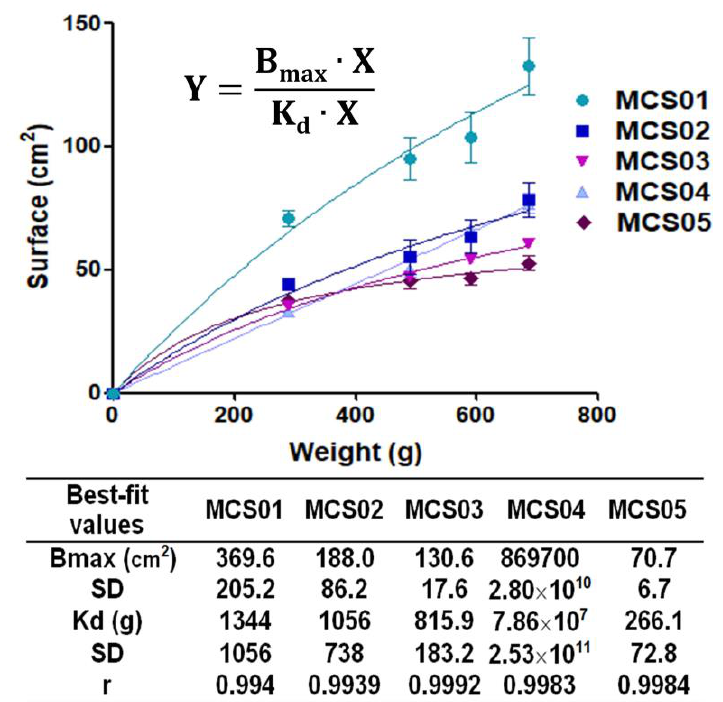
Figure 1. Extensibility results of polymeric solutions (adjusted to hyperbola equation). Data are expressed as mean ± SD ( n = 3). The model fitting of experimental data to the hyperbola equation is also depicted.